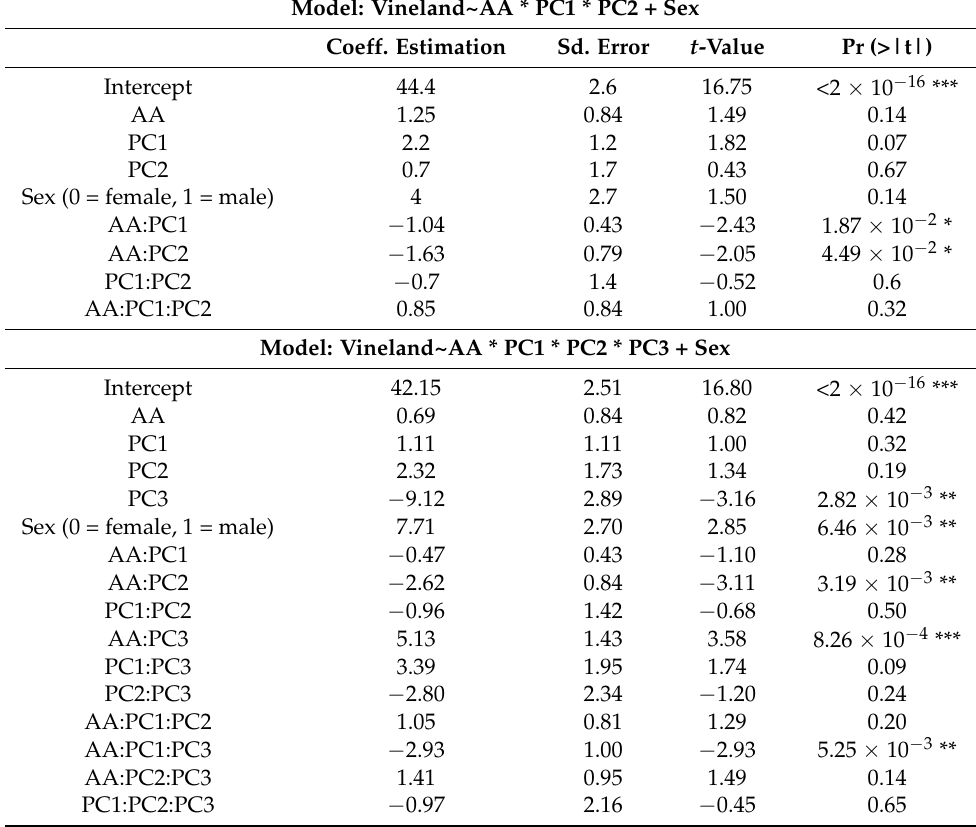
Table 4. Summary of moderation